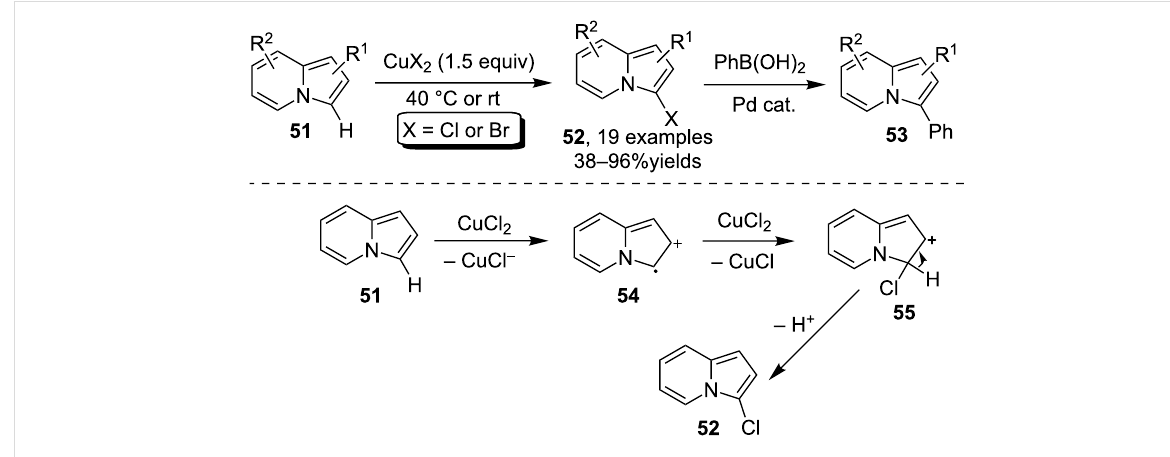
Scheme 18: Copper-mediated chlorination and bromination of indolizines.